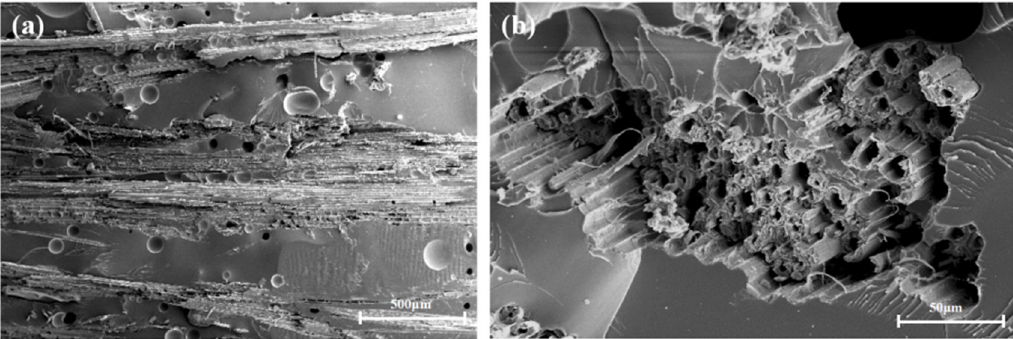
Figure 7. Morphology of the TBF-NOL circumferential composite: ( a ), 50×; ( b ), 500×.